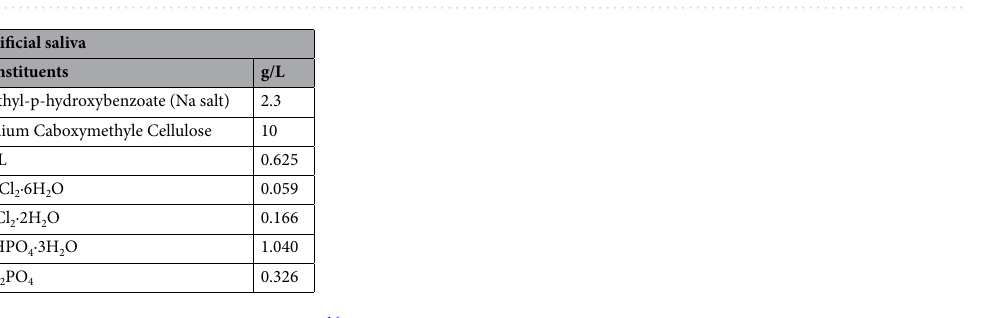
Table 1. Constituents of artificial saliva 16 . Adjustment of pH to 6.75 using 0.1 M, HCL.